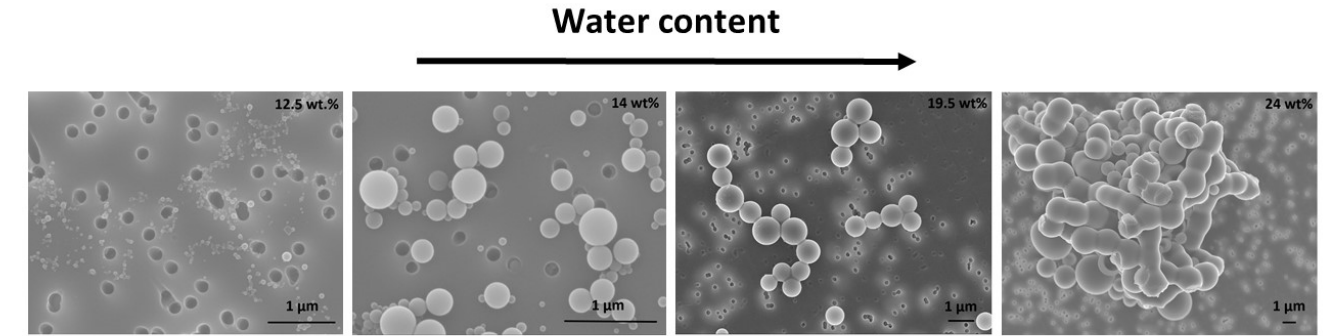
Figure 8. SEM images of mesoscopic PS-b-PAA structures with variation of water content. Spherical micelles (12.5 wt%), vesicles (14 wt% and 19.5 wt%), and large network-like structures (24 wt%).